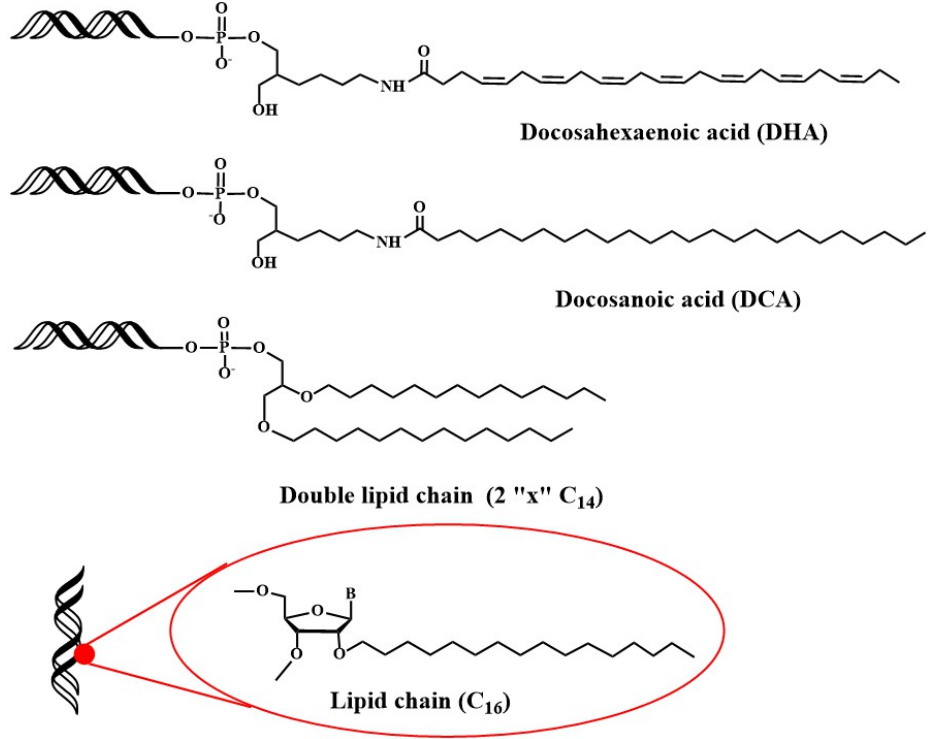
Figure 3. Structure of four different lipid-siRNAs that have been successfully delivered to different cell types and organs [81,92]. cell types and organs